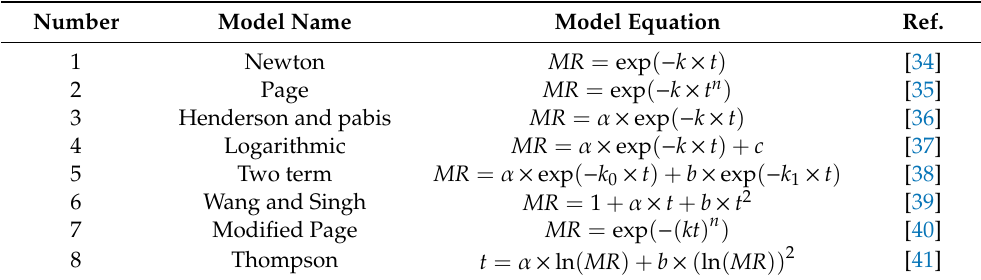
Table 4. Drying curve models for lemon